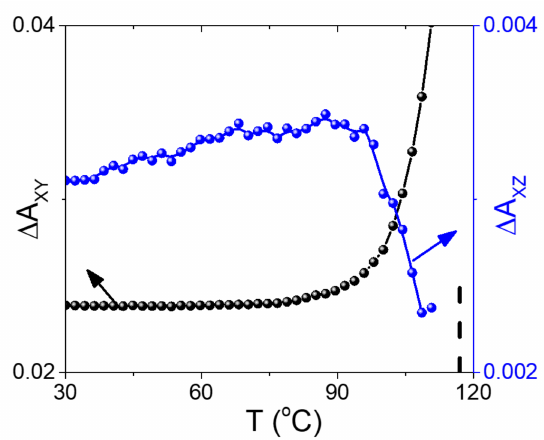
Figure 5. Thermal variation of the two absorption anisotropies, ∆ A XY and ∆ A XZ. The in-plane anisotropy ∆ A XY is about an order of magnitude larger than ∆ A XZ. The two anisotropies have opposite temperature dependence, ∆ A XY increasing and decreasing on approaching T NI (marked as the vertical dash